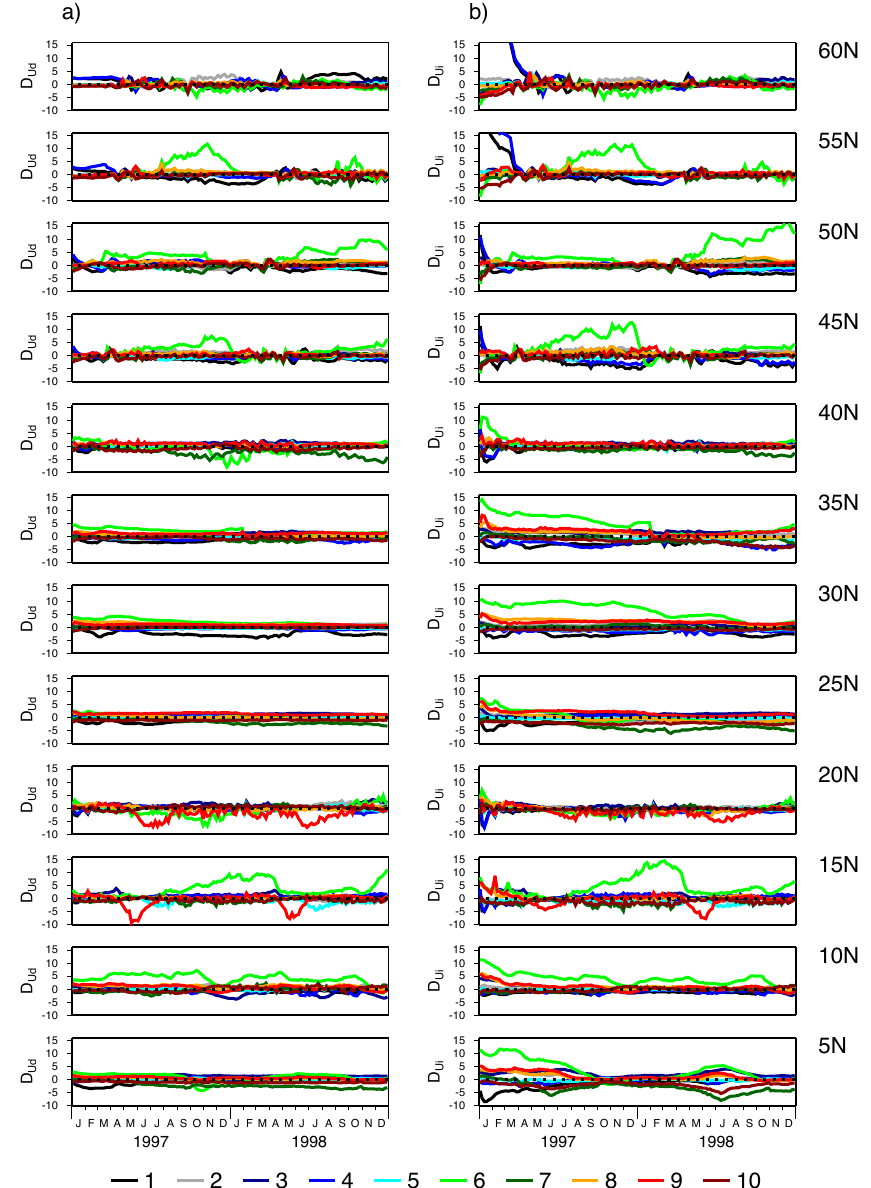
Figure 6. Normalized uninformed emulator error for emulator versions constructed using (a) the direct uncertainty quantification method ( D Ud ) and (b) the indirect uncertainty quantification method ( D Ui ). Errors are shown for the 10 different parameter vectors in Table 2, colour coded by Parameter Set number. Off scale D Ui values not shown at the beginning of 1997 go up to about 26 at 55 ◦ N and about 35 at 60 ◦ N.